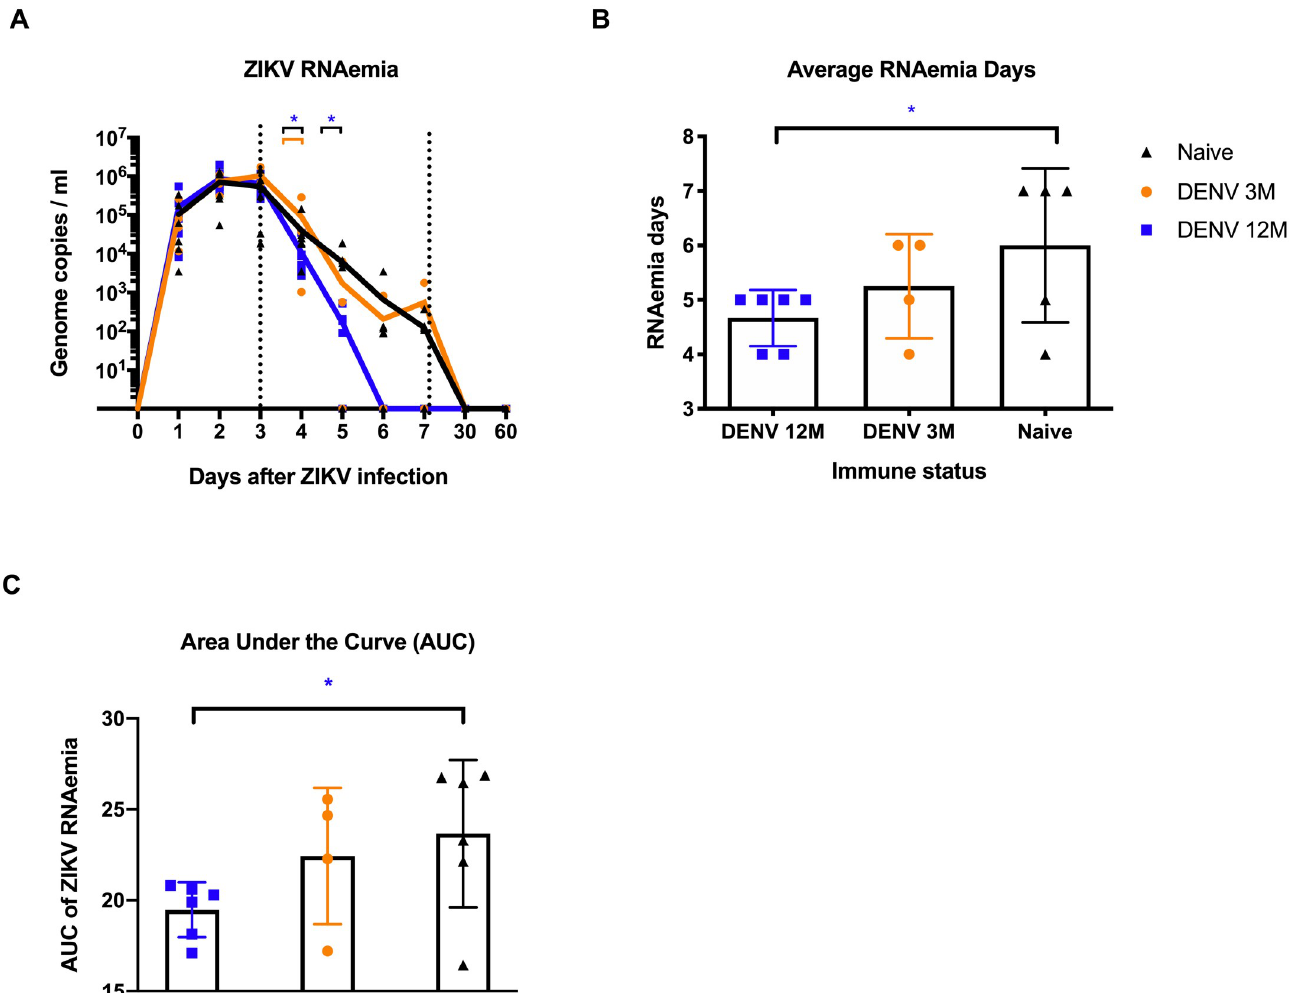
Fig 2. Zika RNA kinetics in serum and RNAemia days per cohort. RNAemia is affected by the period of time between exposures. In all panels, animals exposed to DENV 12 months before ZIKV infection are in blue, while animals exposed to DENV 3 months before are in orange. Na ï ve animals are in black. (A) ZIKV genome copies/mL in serum. ZIKV replication was detected in serum during the first 7 days after infection, and then on days 30 and 60 p.i. Statistically significant differences were observed using unpaired multiple t tests ( � P < 0.05). Genome copies per mL are shown logarithmically. (B) Average RNAemia days were calculated using the following formula: total viremia days divided by total possible viremia days and are expressed as percentage. The obtained values were placed in a contingency table. (C) Area under the curve (AUC) was calculated for individual values. Statistically significant differences of viremia days were calculated using a two-sided Fisher’s exact test and multiple t tests ( � P < 0.05). Colored stars represent a significantly different group, while colored lines represent the group that it is compared to.